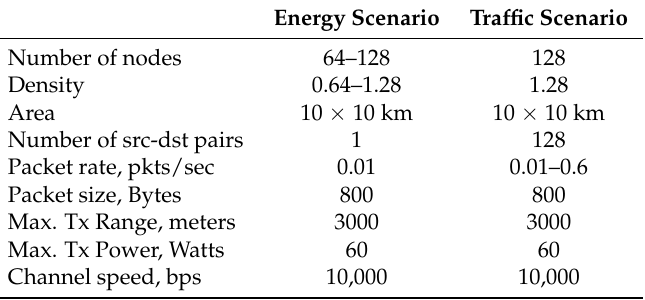
Table 2. Simulation